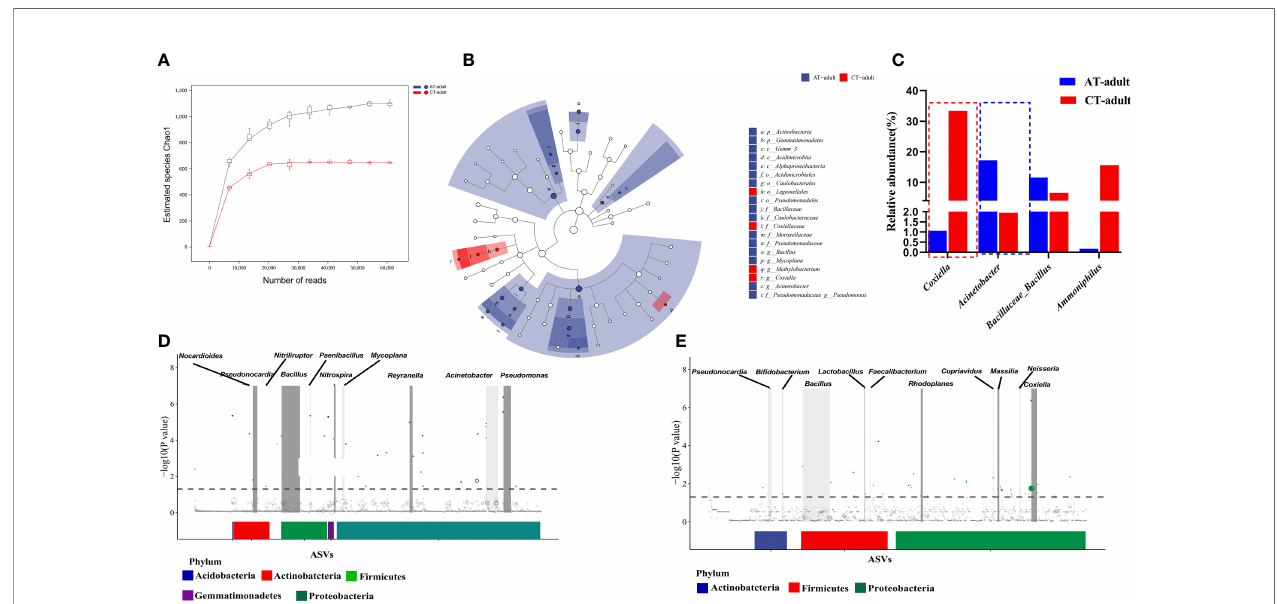
FIGURE 2 | Antibiotics used on mice resulted in tick microbiota dysbiosis. (A) Rarefaction curve of the estimated number of genera using the Chao1 method. (B) Cladogram for taxonomic representation of signi fi cant differences between two groups. (C) Percentages of the most abundant genera in AT adults and CT adults. (D, E) Manhattan plots showing the abundance enrichment in the AT adults (D) and CT adults (E) . The dashed line represents the P = 0.05 threshold of signi fi cance. The color represents the different taxonomic af fi liation of the ASVs (phylum level), and the dot size corresponds to their relative abundance in the respective samples. Gray boxes denote the different taxonomic groups (genus